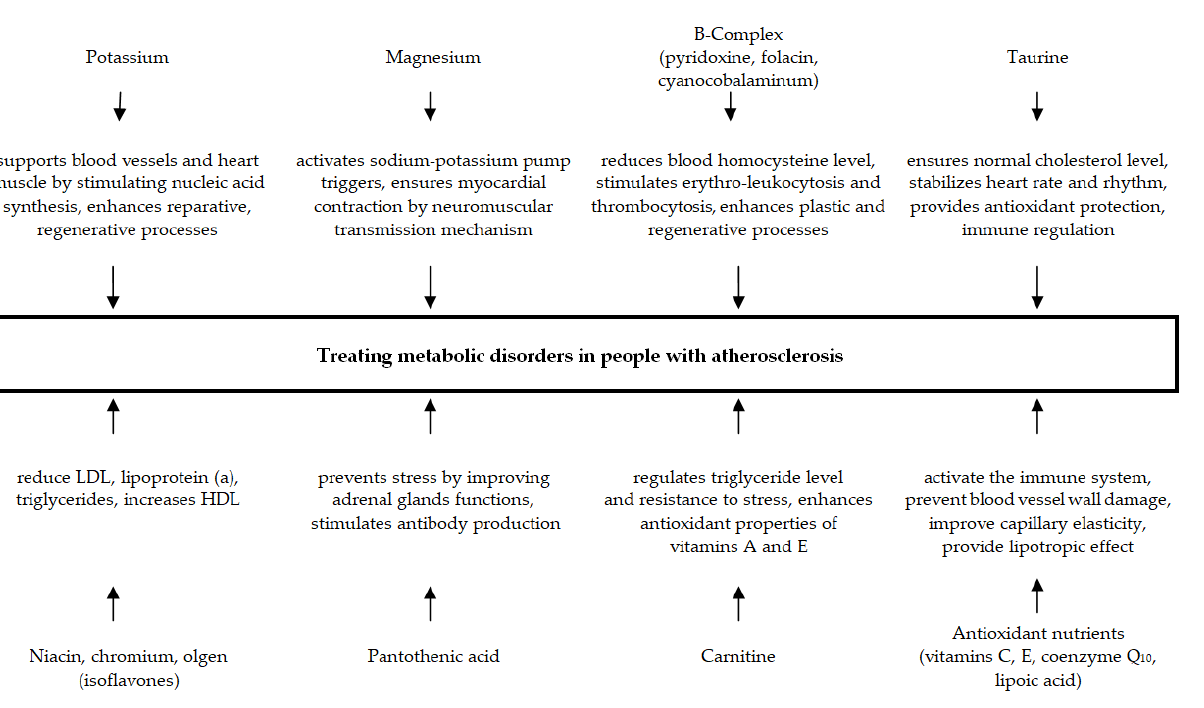
Figure 1. Mechanism of the food supplement influence on improving metabolism disorders in people with peripheral atherosclerosis.